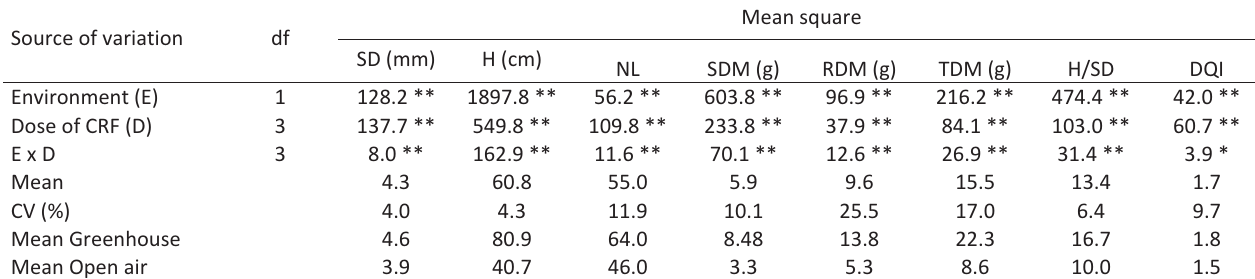
* Significant at the probability level (p<0.01) and ** significant at the probability level (p<0.05) by the